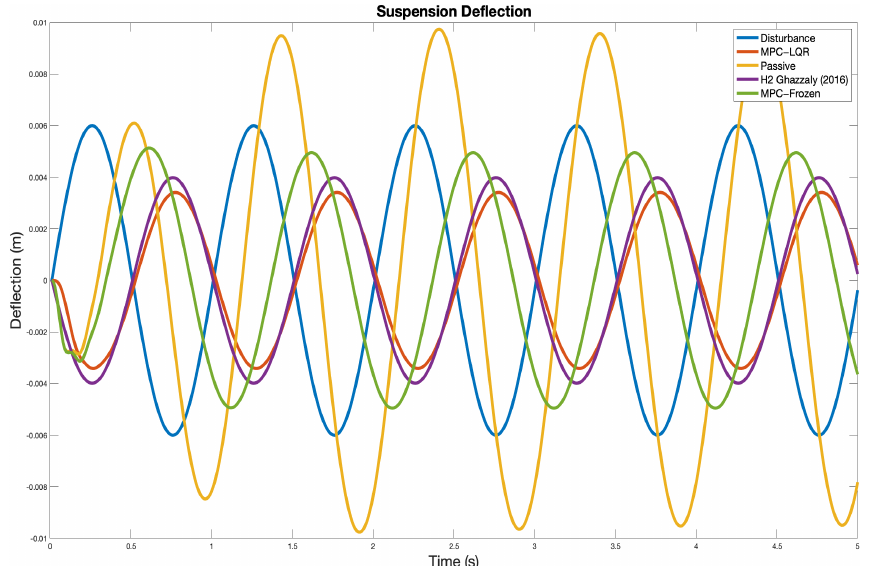
Figure 11. Suspension Deflection—Sinusoidal Disturbance (Blue—disturbance, Red—MPC-LQR, Yellow—Passive, Purple—H2,